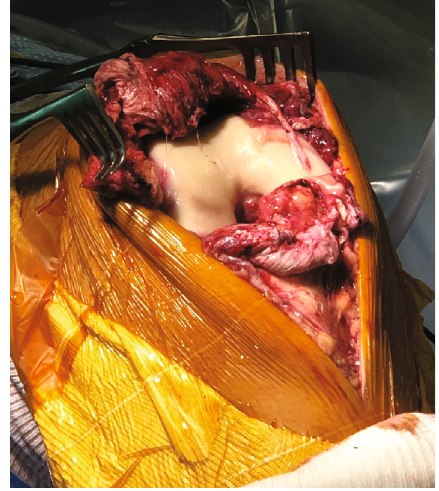
Figure 2: Intraoperative photo showing the ruptured patellar tendon of the right